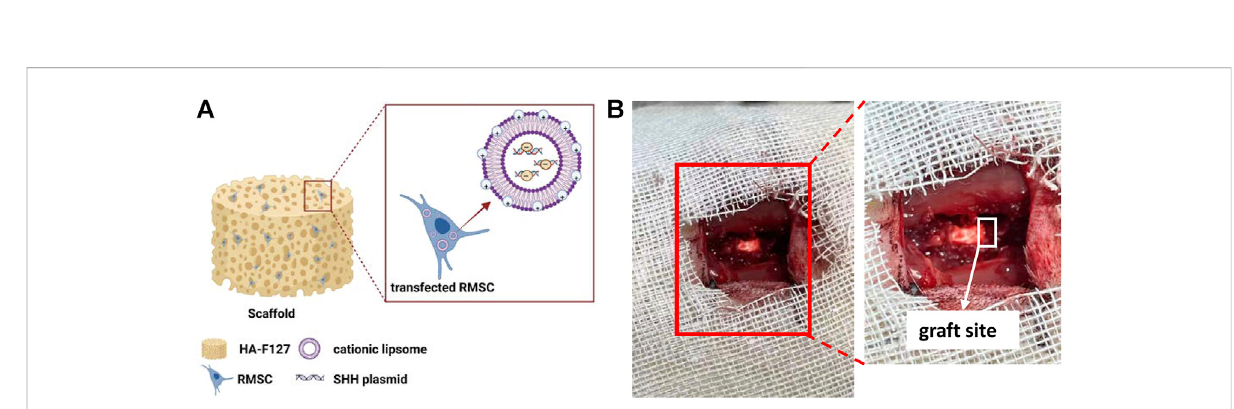
FIGURE 8 The schematic diagrams. (A) The composition of graft; (B) The graft site in spinal cord injury models.